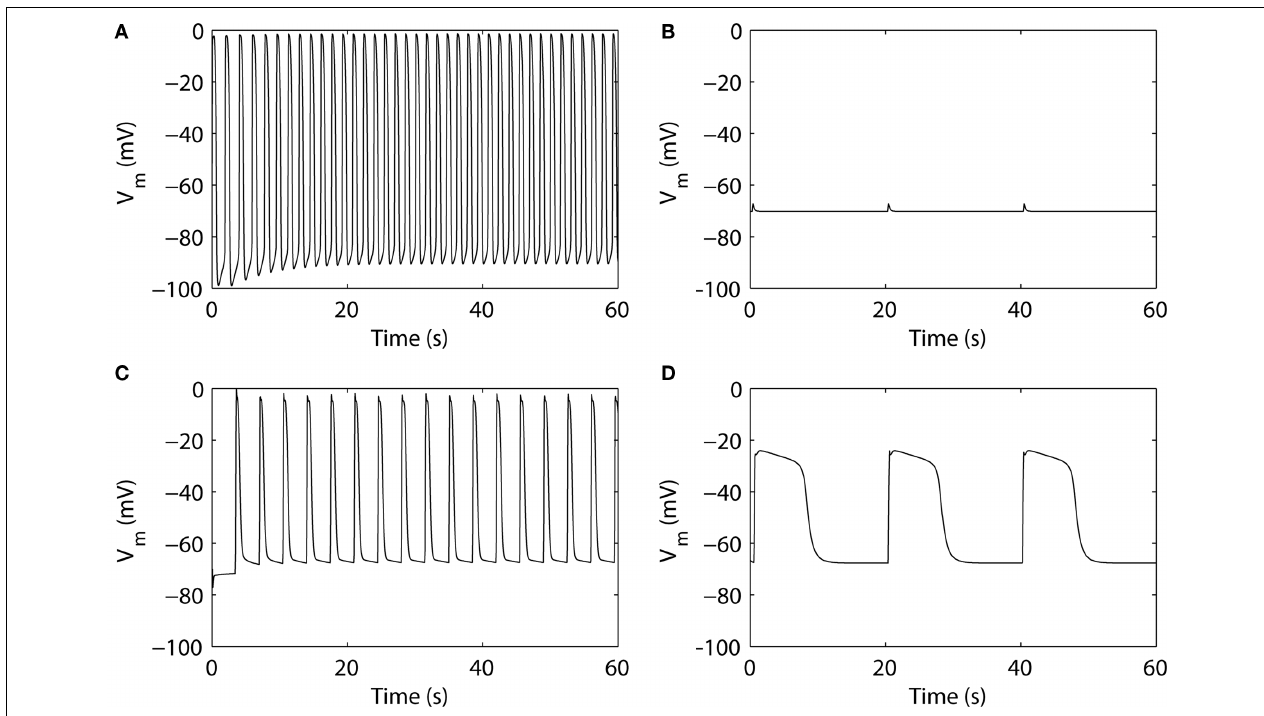
FIGURE 5 | Simulated slow wave activities. (A) The ICC model byYoum et al. (2006). (B) The pacemaker unit model by Faville et al. (2008) at gastric slow wave frequency. (C) The bulk cytoplasm ICC model by Faville et al. (2009) at intestinal slow wave frequency. (D) The ICC model by Corrias and Buist